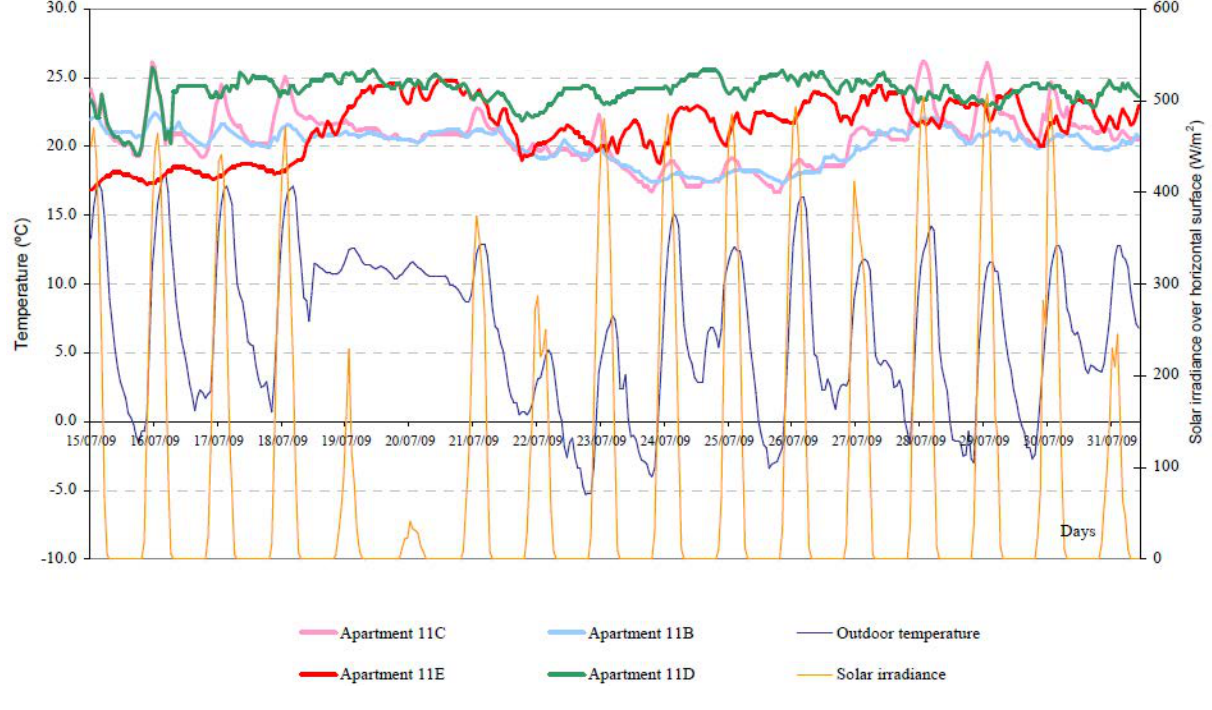
Figure 5. Thermal behavior between 15 July 2009 and 31 July